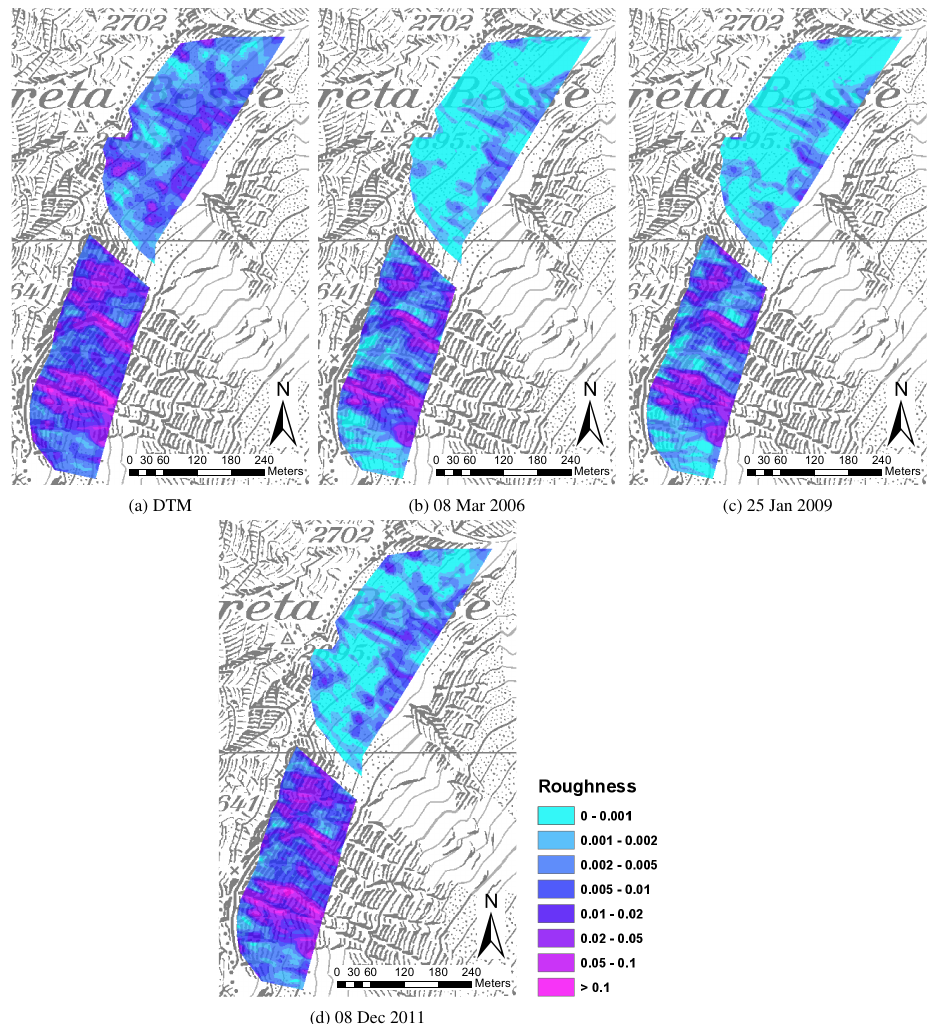
Fig. A6. Surface roughness of summer terrain and winter terrain at a scale of 15m in basins CB1 and CB2. Pixmaps © 2013 swisstopo (5704 000 000).